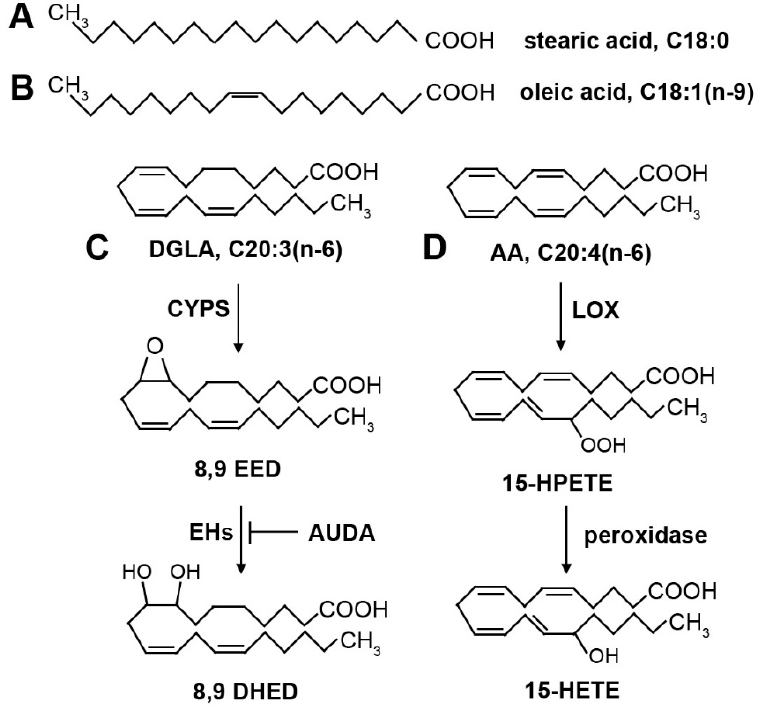
Figure 2. Structures of common fatty acids and oxygenated derivatives. ( A ) Stearic acid (18:0) is a saturated fatty acid. ( B ) Oleic acid (18:1n-9) is a monounsaturated fatty acid. The single double bond is in the cis position, creating a kink in the fatty acid that prevents tight packing of fatty acids and contributes to membrane fluidity. ( C ) Dihommo- γ linolenic acid (DGLA, 20:3n-6) is a polyunsaturated fatty acid. Oxygenated derivatives are produced by cytochrome P450 (CYP) enzymes, forming an epoxide. The double bond that is converted to an epoxide depends on the position-specific isoform of CYP enzymes. The epoxides can be converted into diols by epoxide hydrolase (EH) enzymes. The EH enzymes are inhibited by AUDA. ( D ) Arachidonic acid (AA, 20:4n-6) is a polyunsaturated fatty acid. Shown are examples of oxygenated derivatives produced by lipoxygenase (LOX) enzymes and peroxidase activity. The location of the hydroperoxide is dependent on the position-specific isoform of LOX. The hydroperoxide can be further reduced by peroxidase activity, leading to a bioactive hydroxyl derivative.